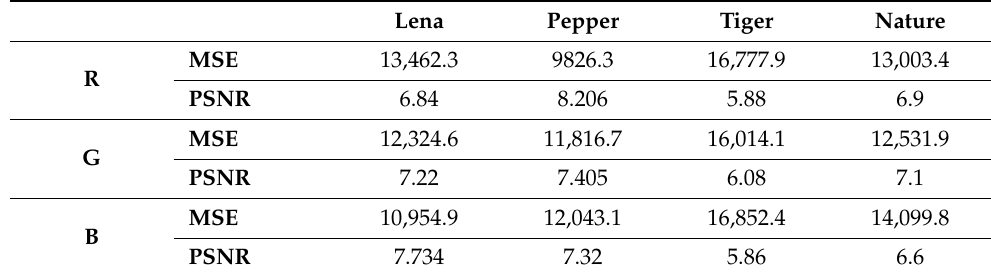
Table 9. Demonstrated values of PNSR and